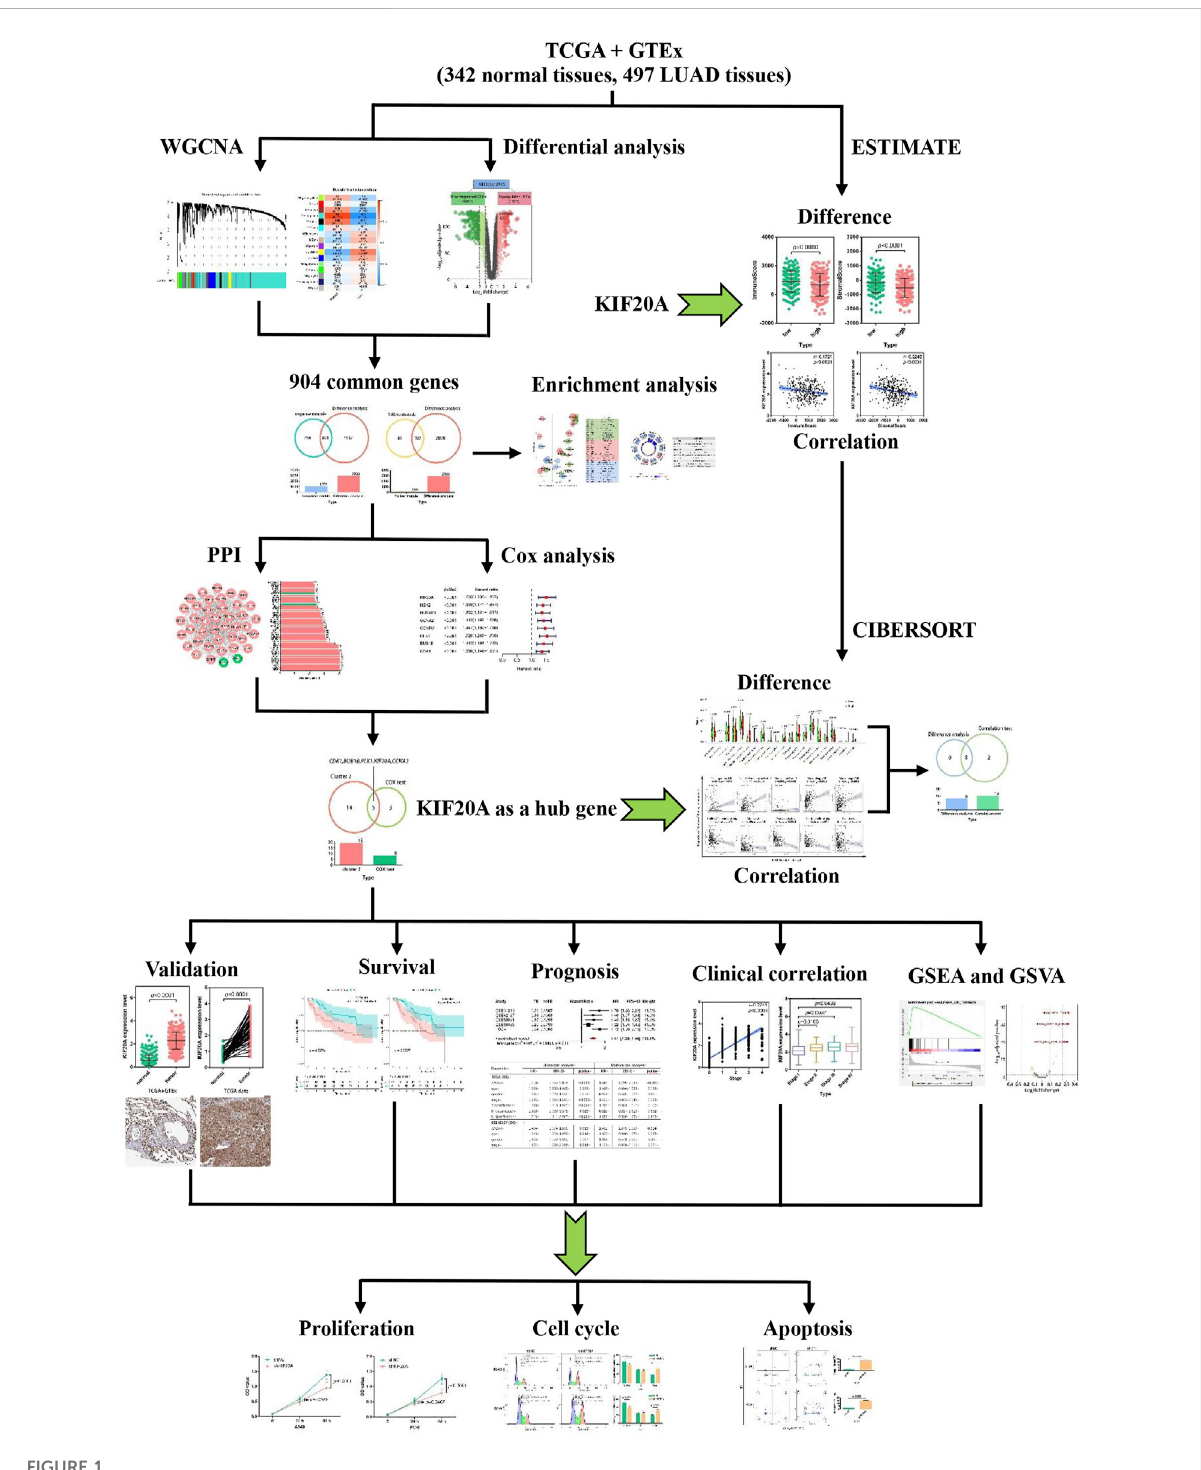
FIGURE 1 Flowchart for the work in lung adenocarcinoma